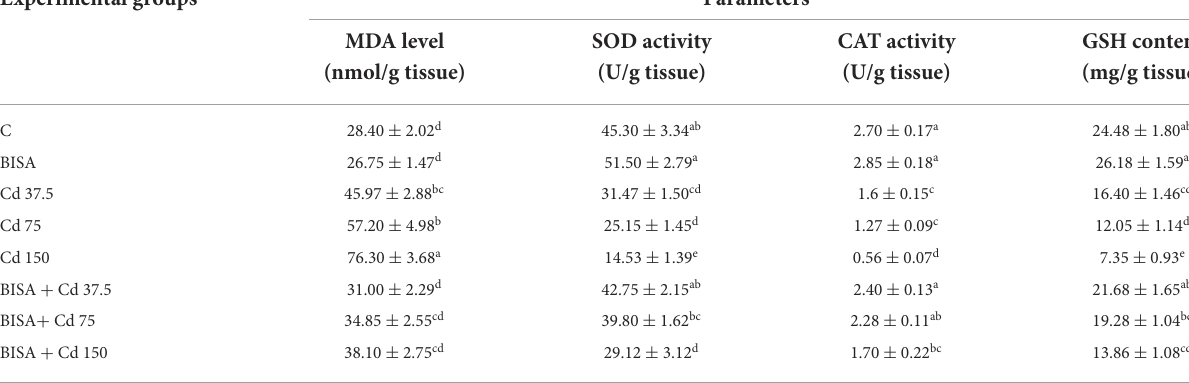
TABLE 4 Effect of α -bisabolol on hepatic tissue oxidative stress markers in ducks receiving CdCl 2 in feed for 4 weeks. Experimental groups